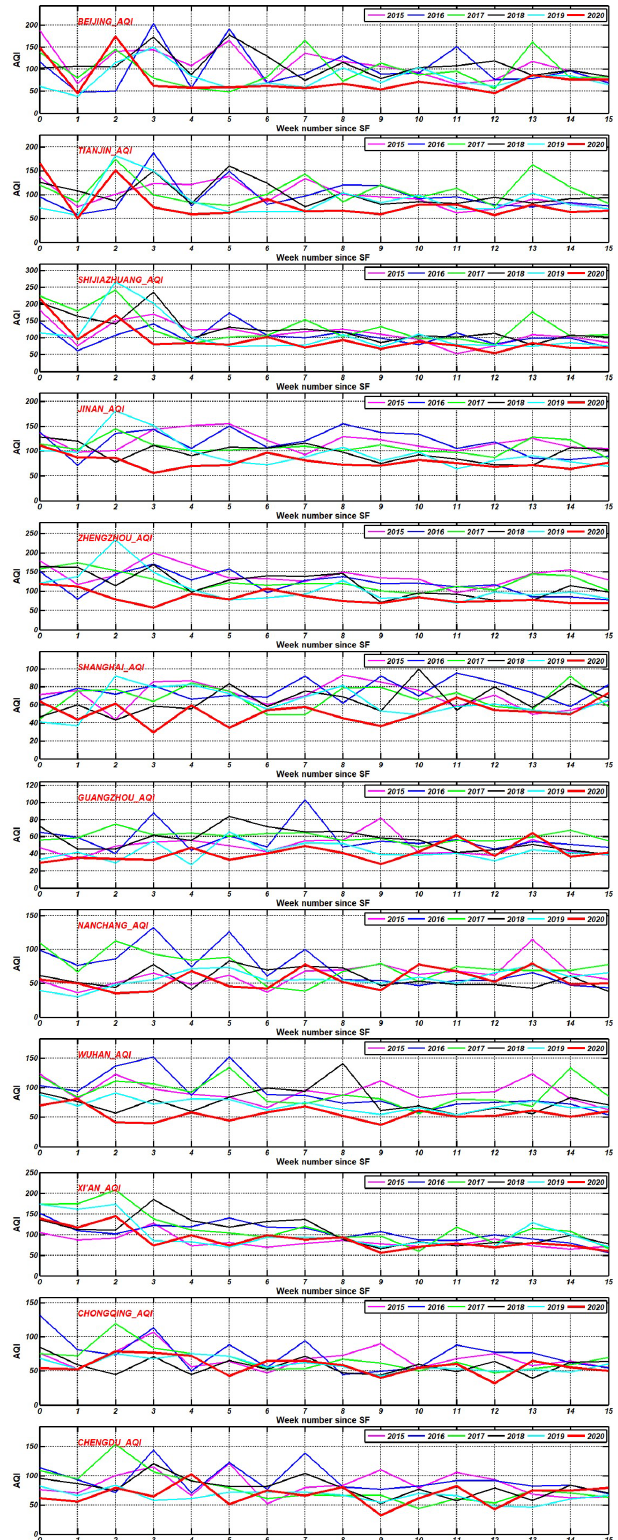
Figure A4. Time series of the AQI in 12 cities for the first 16 weeks (week 0 to week 15) after the Spring Festival in 2020, together with AQI time series for the same weeks in 2015–2019. See legend for identification. Note that the vertical scales vary between different